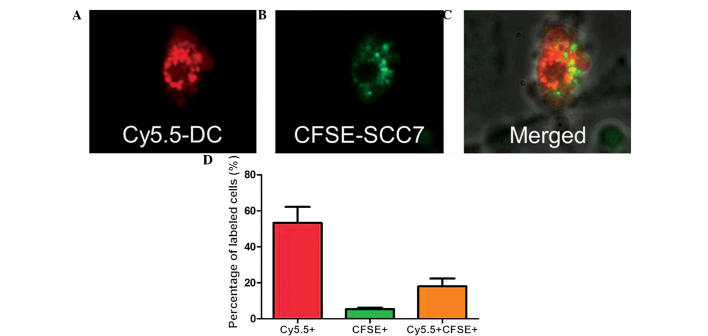
DCs labeled with Cy5.5 were fused with CFSE-SCC7 by PEG at a ratio of 3:1 and fusion preparations were cultured overnight. The representative fluorescence photomicrographs showed (A) DCs labeled with Cy5.5, (B) SCC7 cells stained with CFSE and (C) DC/SCC7 fused cells (magnification, ×2,400). (D) Fusion efficiency was determined by FACS and the results were counted. DCs, dendritic cells; PEG, 50% polyethylene glycol.